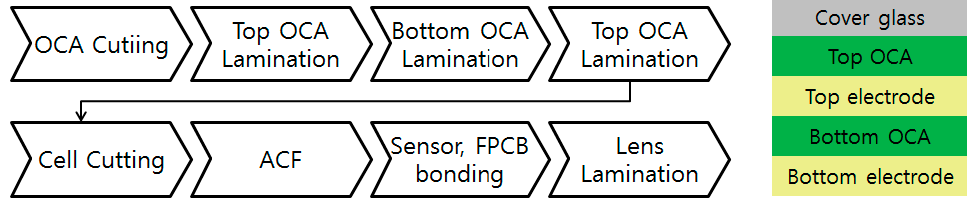
Figure 4. Structure and fabrication process of touch screen panel. ACF: anisotropic conductive film; OCA: optically clear adhesive.